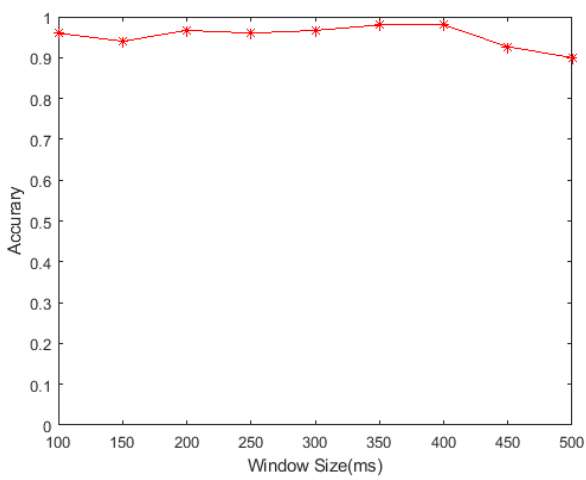
Figure 8. Window size test recognition rate (Subject 1).